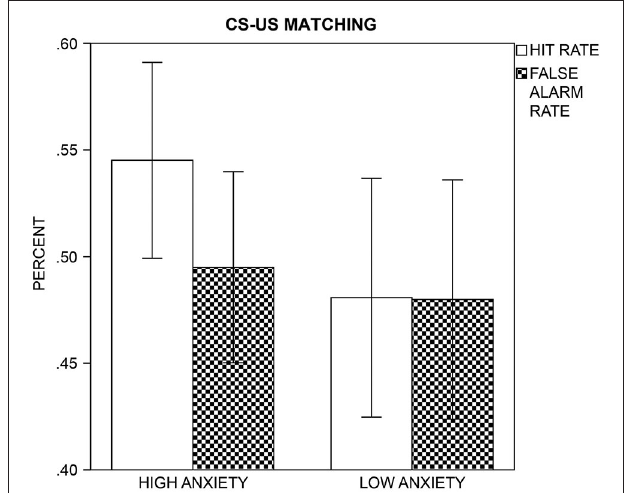
FIGURE 5 | CS-US Matching . The mean hit (white bars) and false alarm (patterned bars) rates with a 95% confidence interval are displayed for the high and low anxiety